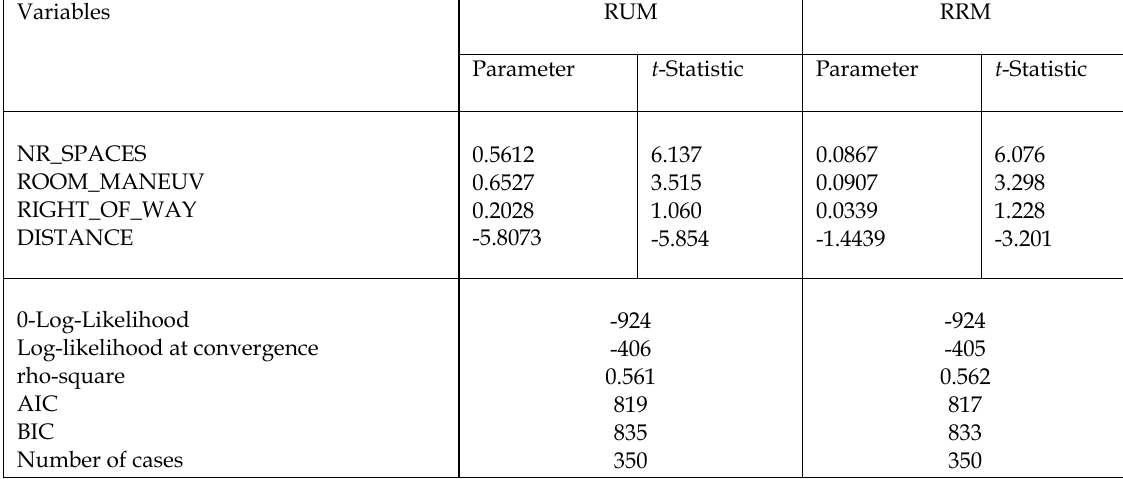
RUM RRM Variables Parameter t -Statistic